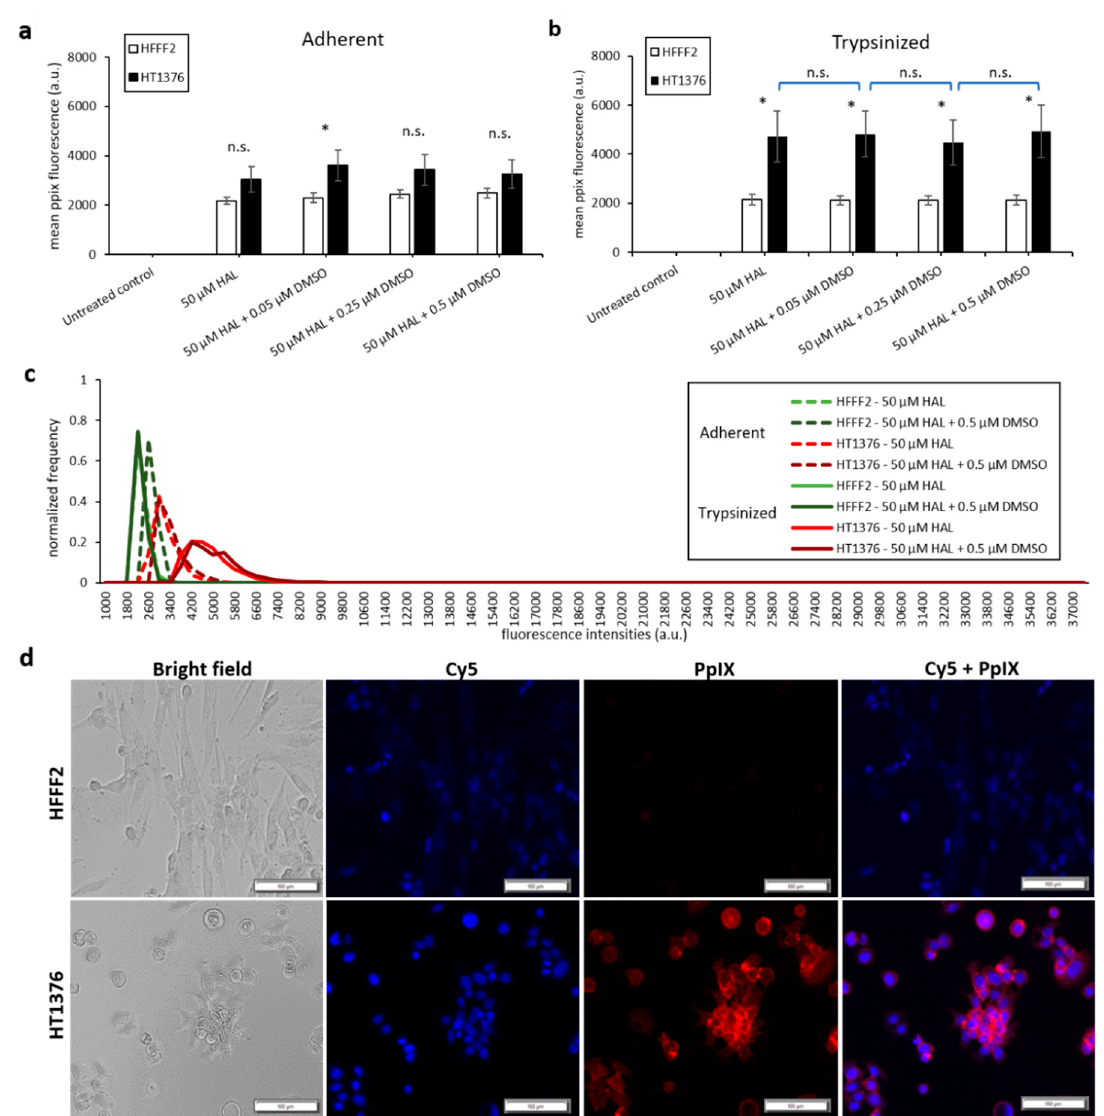
Figure 3. Effect of DMSO and HAL treatment on PpIX fluorescence in human bladder cancer HT1376 and human fibroblast HFFF2 cells. Cells were incubated with HAL (50 µM) alone or HAL (50 µM) and different concentrations of DMSO (0.05 to 0.5 µM) in PBS for 2 h. Mean ±SD ( n = 3), statistical significance by ANOVA. n.s . = not significant and * p < 0.05, compared between bladder cancer HT1376 and noncancer fibroblast HFFF2 in the same conditions. PpIX fluorescence was measured in adherent ( a ) and trypsinised ( b ) cells. Results are expressed in bar and ( c ) histogram (50 µM HAL + 0.05/0.25 µM DMSO not shown) graphs. ( d ) Microscopic images showing the PpIX fluorescence in adherent monolayer bladder cancer HT1376 cells after combined treatment with HAL and 0.5 µM DMSO compared to foreskin fibroblast HFFF2 cells (trypsinised cells images not shown). Scale bars represent 100 µm, magnification is 10X.